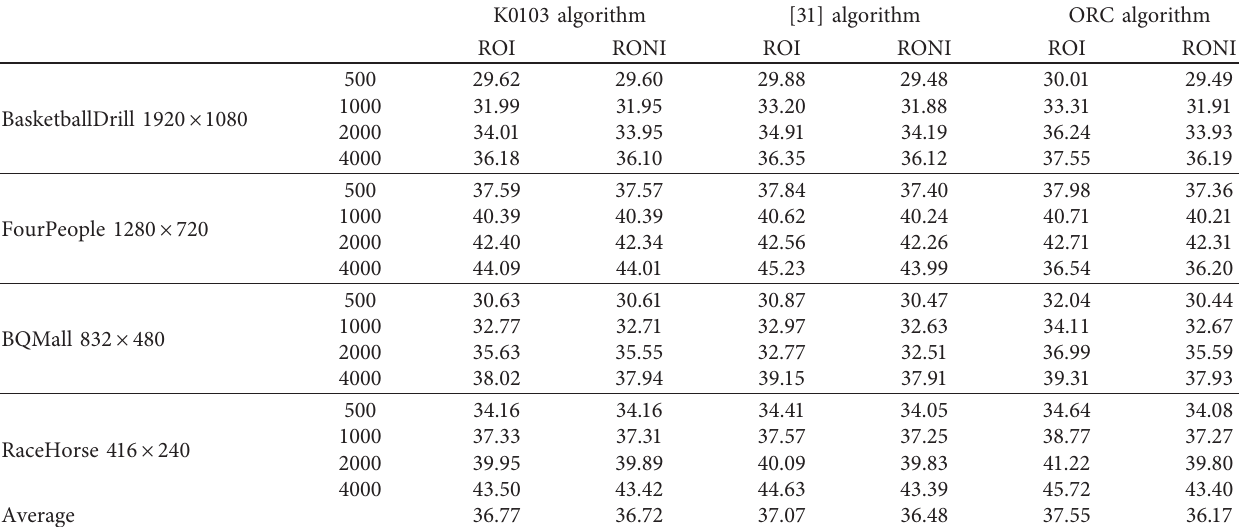
Figure 8: The comparison of Y-PSNR among three algorithms. The comparison of Y-PSNR in (a) the BasketballPass sequences, (b) the Kimono sequences, (c) the BasketballPass sequences, and (d) the Kimono sequences. Table 4: Experimental results among the ORC algorithm, the K0103 algorithm, and algorithm in [31].